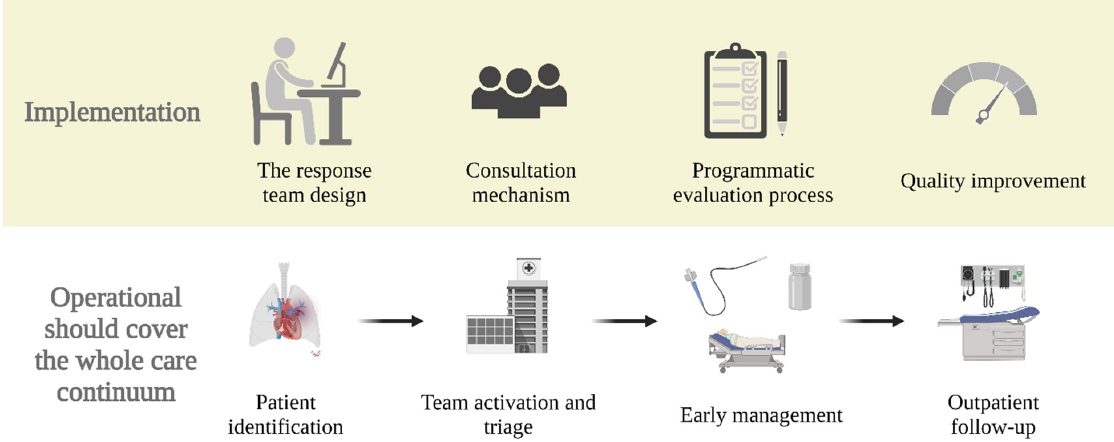
Figure 3. Structure and development of a PE response team. PE = pulmonary